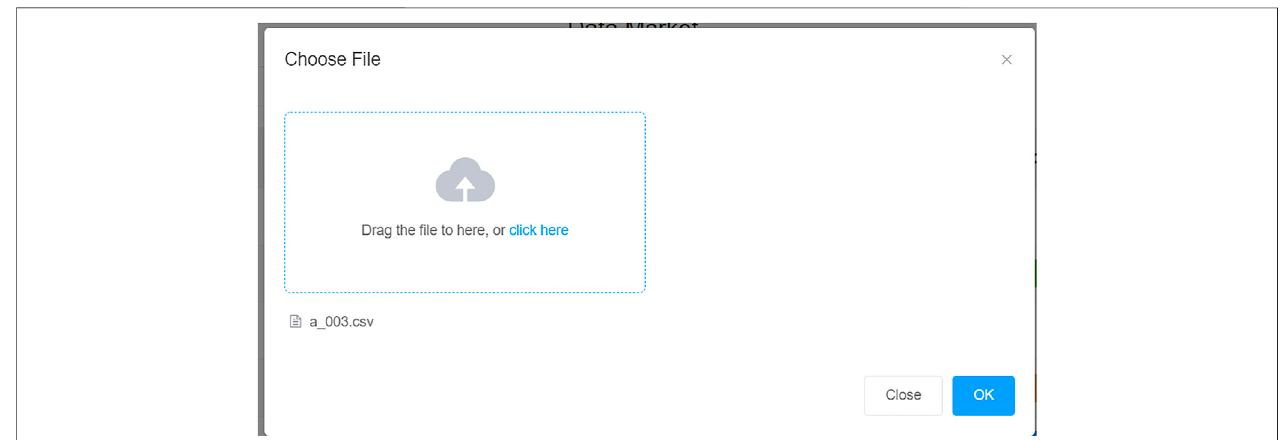
FIGURE 4 | Data storage and release for consortium members. The framework adopted a distributed storage system, with massive personal health data mainly stored in the local server of consortium members.